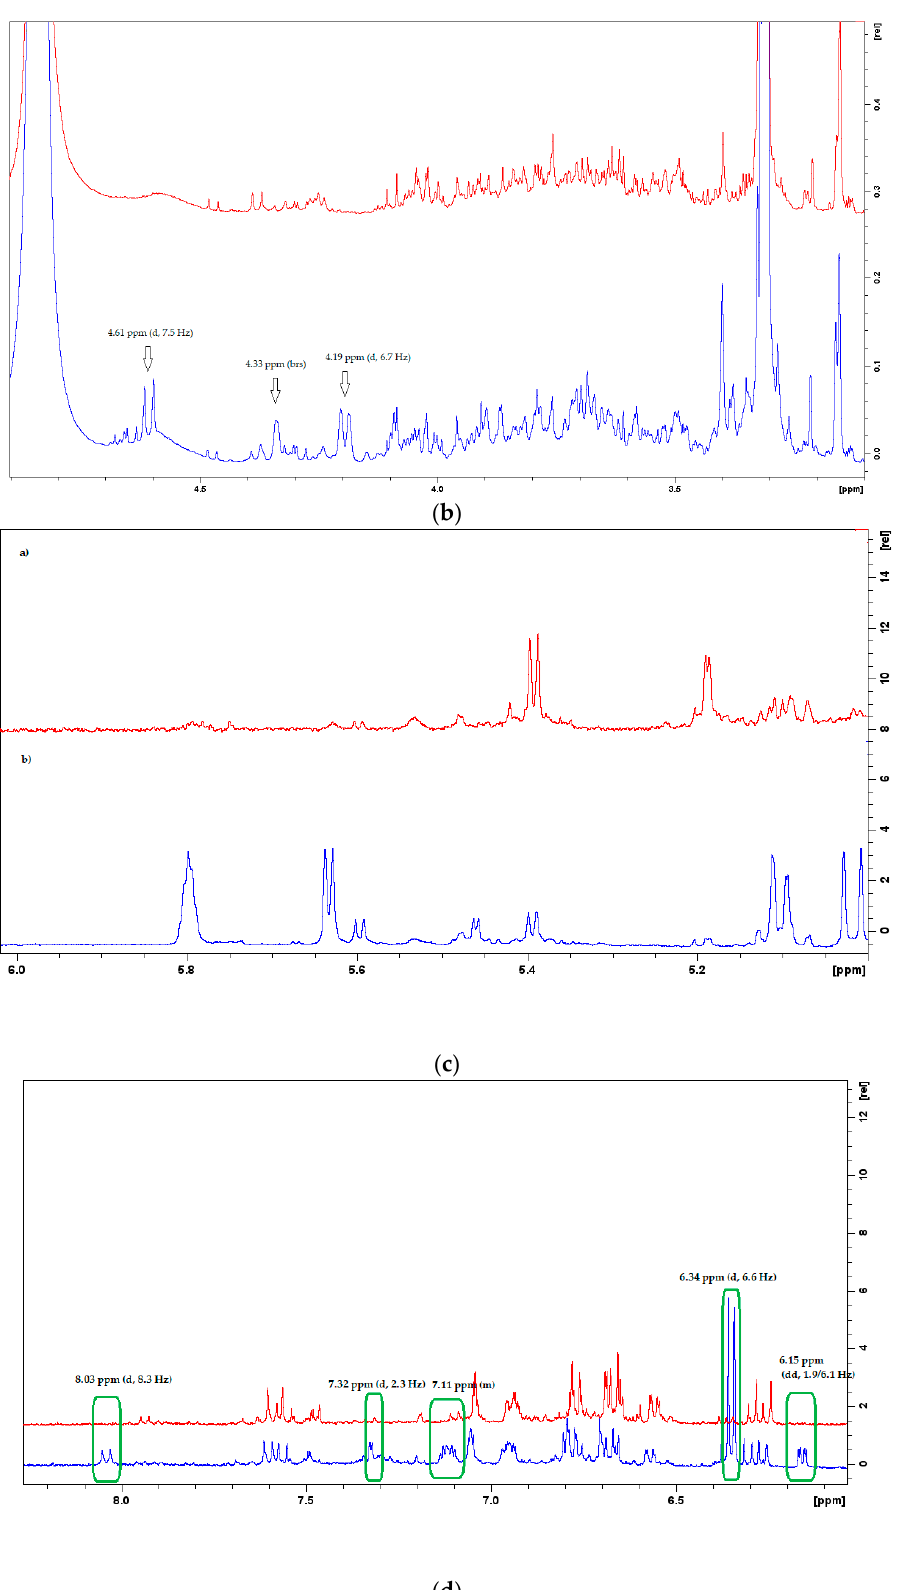
Figure 2. Overlaid 1 H-NMR spectra of S. cypria (red colour) and S. perfoliata subsp. perfoliata (blue colour) infusions. ( a ) Zoom-in of the region between 0.7 and 3.0 ppm; ( b ) Zoom-in of the region between 3.1 and 4.9 ppm; ( c ) Zoom-in of the region between 5.0 and 6.0 ppm; ( d ) Zoom-in of the region between 6.1 and 8.0 ppm. The different peaks were signed in green